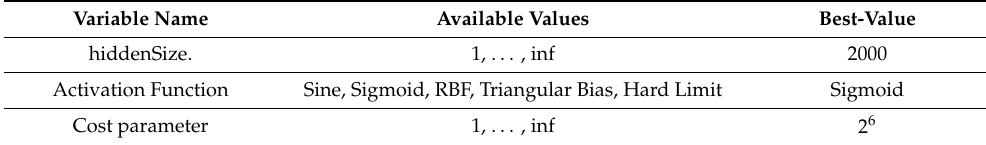
Table 3. ELM Hyperparameters [54].